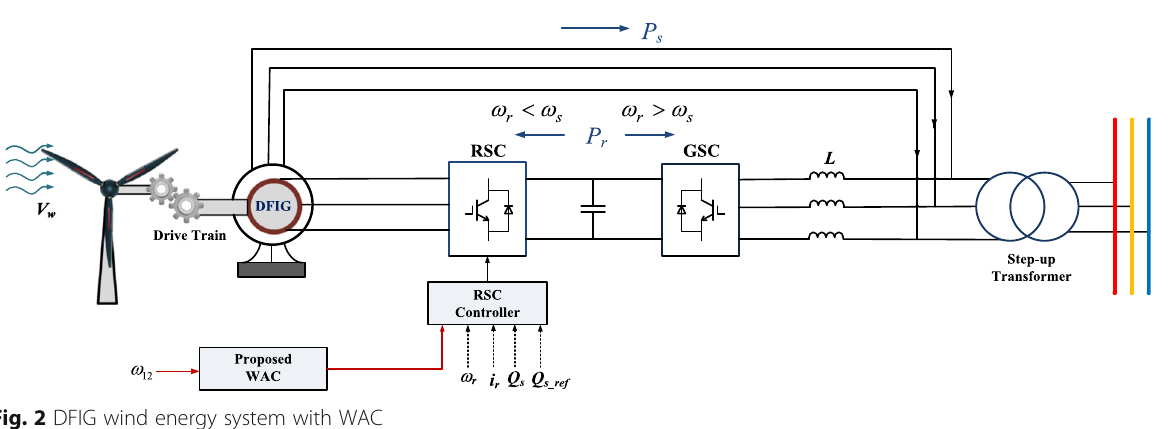
Fig. 2 DFIG wind energy system with WAC